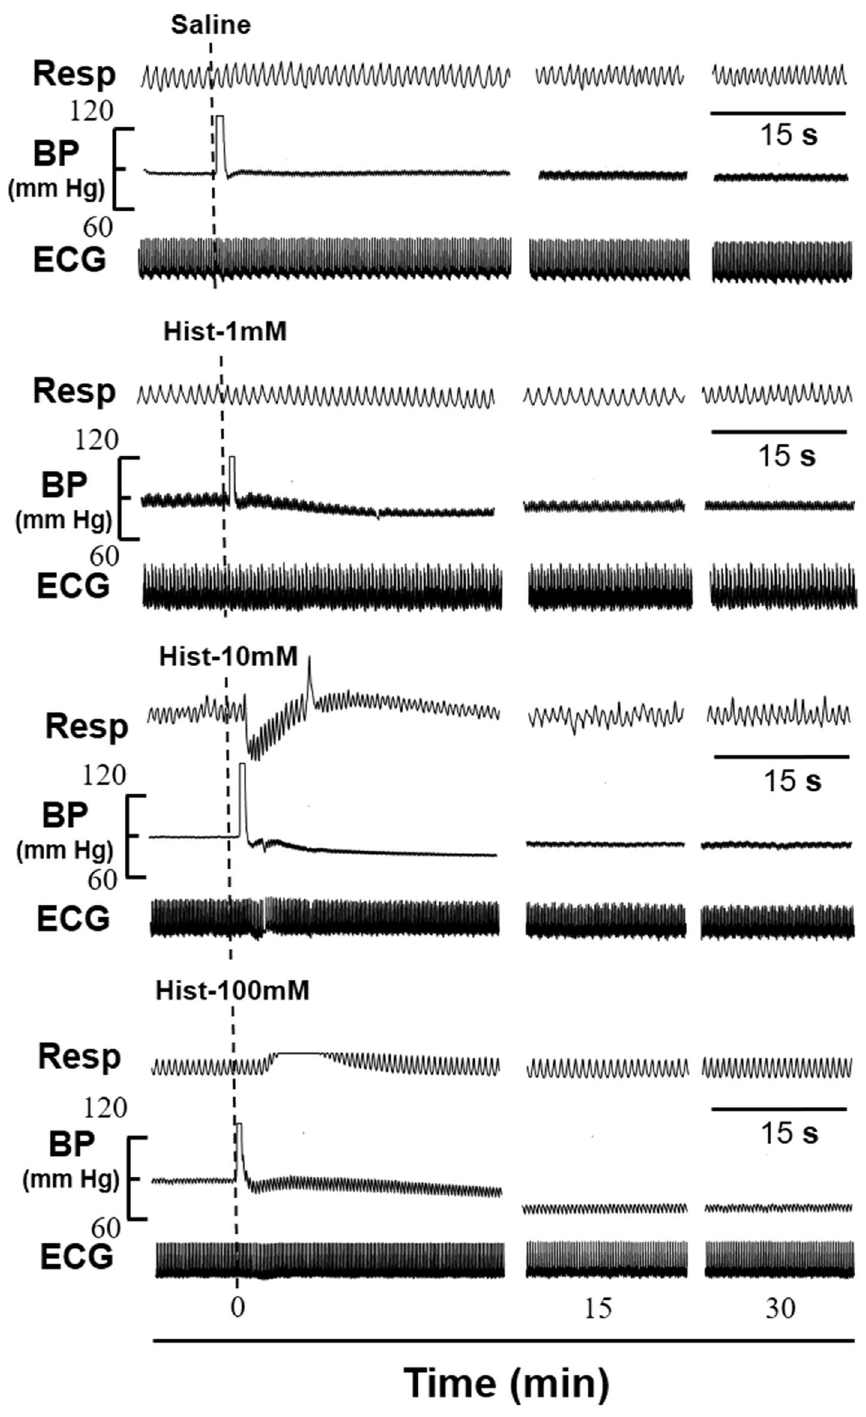
Figure 2. Representative prototypes of original recordings showing the effects of different concentrations of histamine (Hist) on respiration (Resp), blood pressure (BP) and electrocardiogram (ECG) as compared to normal saline control. The responses are shown at different time intervals as indicated in the lower panel. The points of instillation are shown by dotted lines. The horizontal line in each panel is 15 s for all